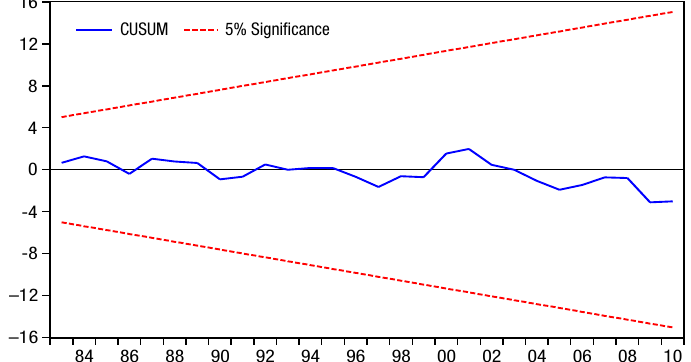
Fig. 5. Plot of cumulative sum of recursive residuals. The straight lines represent critical bounds at 5% significance level